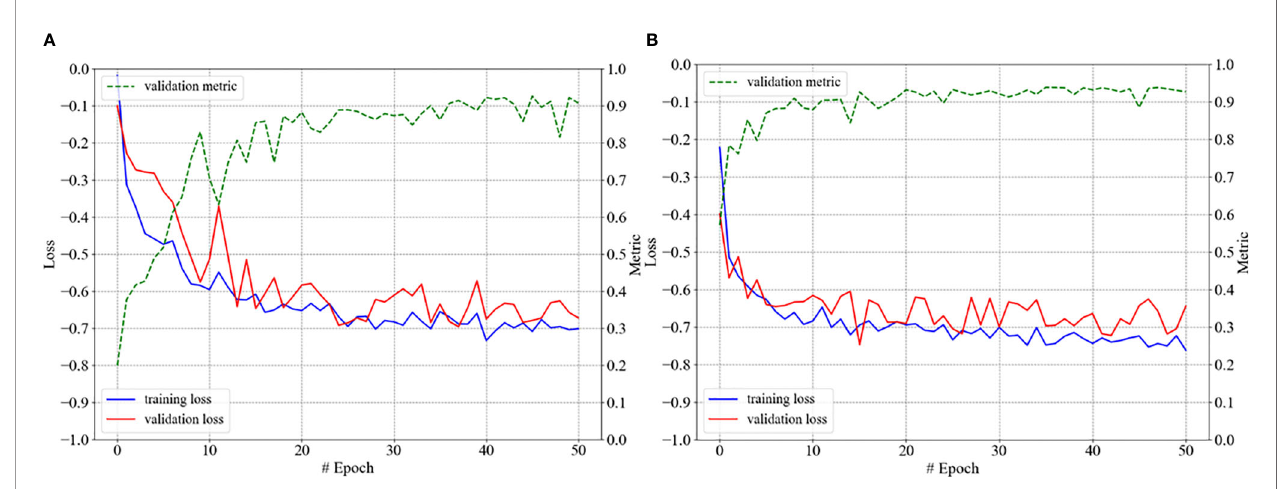
FIGURE 4 | The training processes of model-glioma (A) and model-glioma-TL (B) .